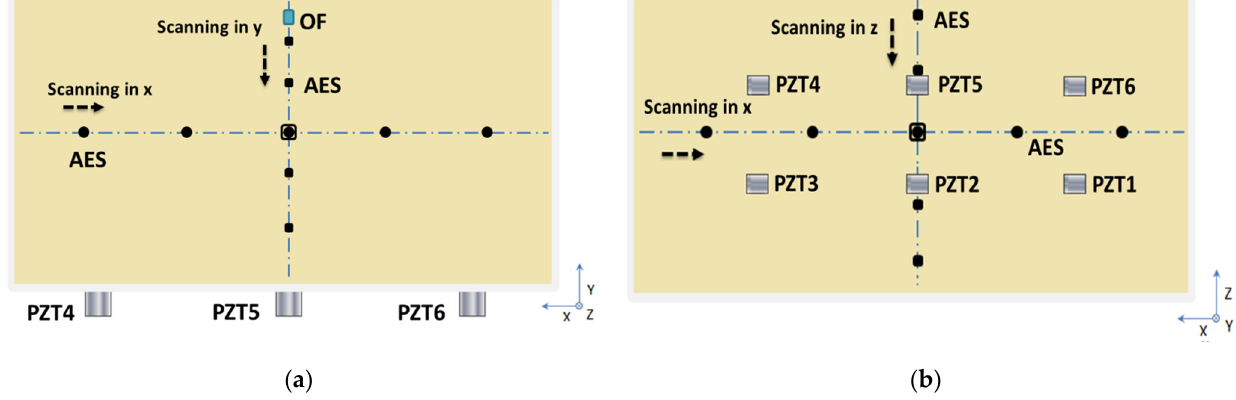
Figure 12. Sweep of the AES position within the tank, scanning XY (top view) in ( a ) and scanning XZ (front view) in ( b